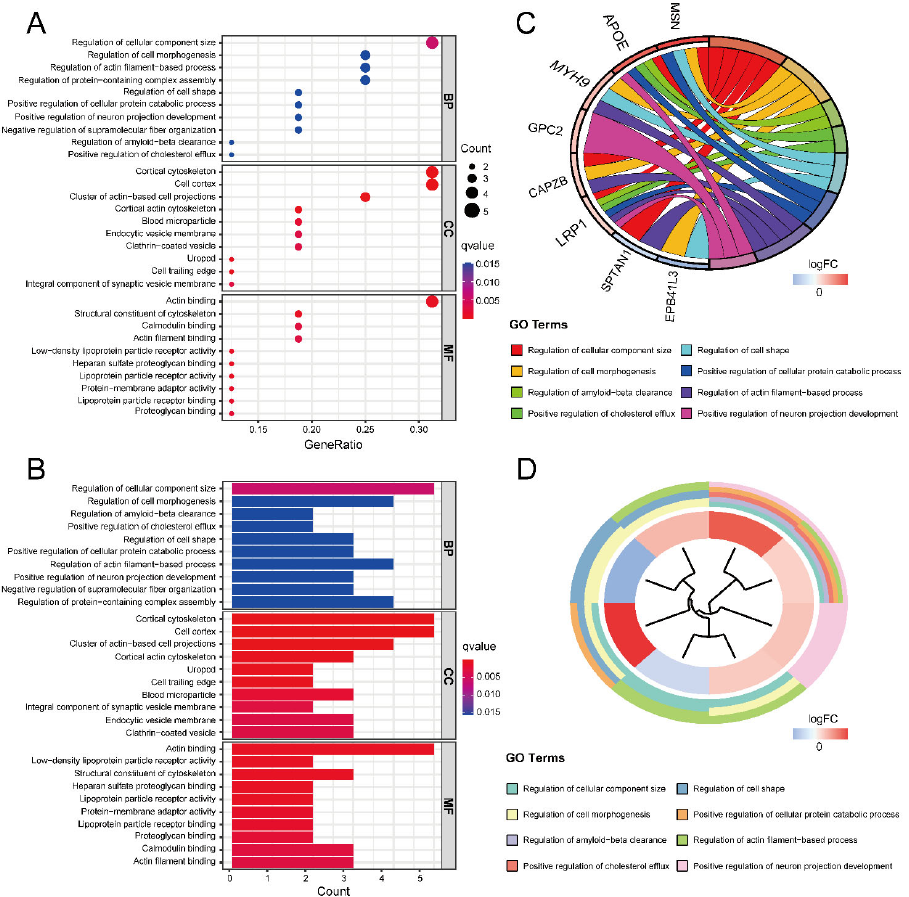
Figure 4. The results of GO enrichment analysis. ( A ) GO enrichment bubble plot, which includes a biological process (BP), molecular function (MF) and cellular component (CC) categories. The x ‐ axis represents the gene ratio, and the y ‐ axis represents the q ‐ value of different GO items. The size of the bubble indicates the number of genes enriched for each GO term. The redder the color, the smaller the q ‐ value. ( B ) GO enrichment bar graph. The redder the color, the smaller the q ‐ value. ( C ) GO enrichment chord plot. Genes are shown on the left, where red gene bands indicate up ‐ regulated expression, and blue gene bands indicate down ‐ regulated expression. The different colored bars on the right represent different GO terms. Lines connect genes and their corresponding GO terms. ( D ) GO enrichment phylogenetic plot. The bands with different colors in the innermost circle represent different genes, and the bands with different colors in the outer circle represent the GO items enriched by the corresponding genes.